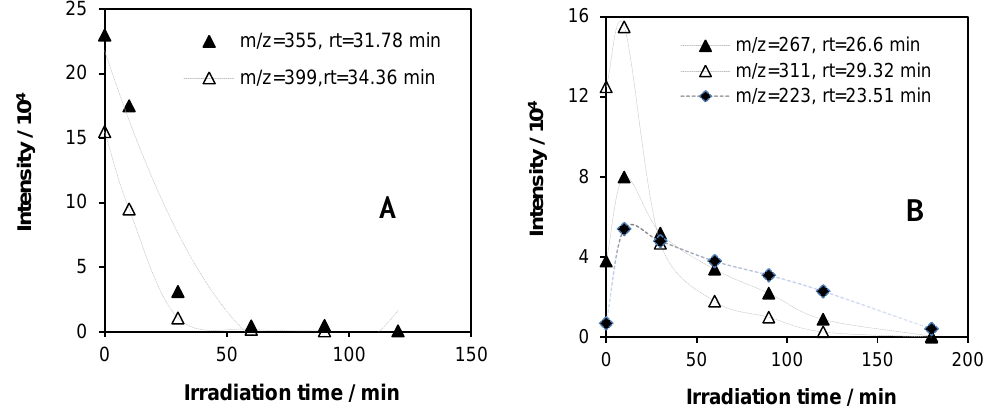
Figure 14. Intensity vs. irradiation time plots for the most abundant fragment ion of the starting components of Triton X-100 with molecular weights of 470 ( m / z = 399), 426 ( m / z = 355) ( A ) and 382 ( m / z = 311), 338 ( m / z = 267) and 294 ( m / z = 223) ( B ) in the photocatalysis of the system containing 2 × 10 −4 mol·dm −3 Triton X-100 and 1 g·dm −3 TiO 2 .